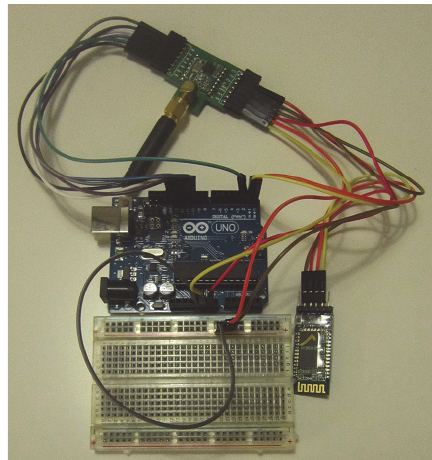
Figure 8: Real-time implementation of reader